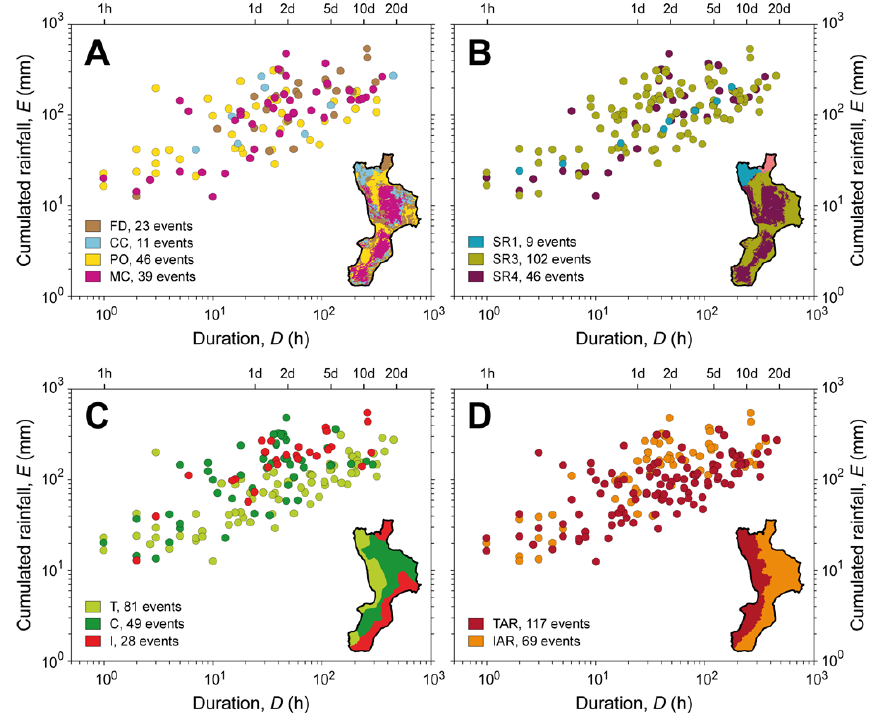
Fig. 7. Rainfall duration vs. cumulated event rainfall ( D,E) conditions that resulted in shallow landslides in Calabria for different environ- mental factors. (A) Four lithological domains. (B) Four soil regions. (C) Three rainfall regions. (D) Two Civil Protection alert regions. See Fig. 6 for location of the environmental factors and for colour legends.